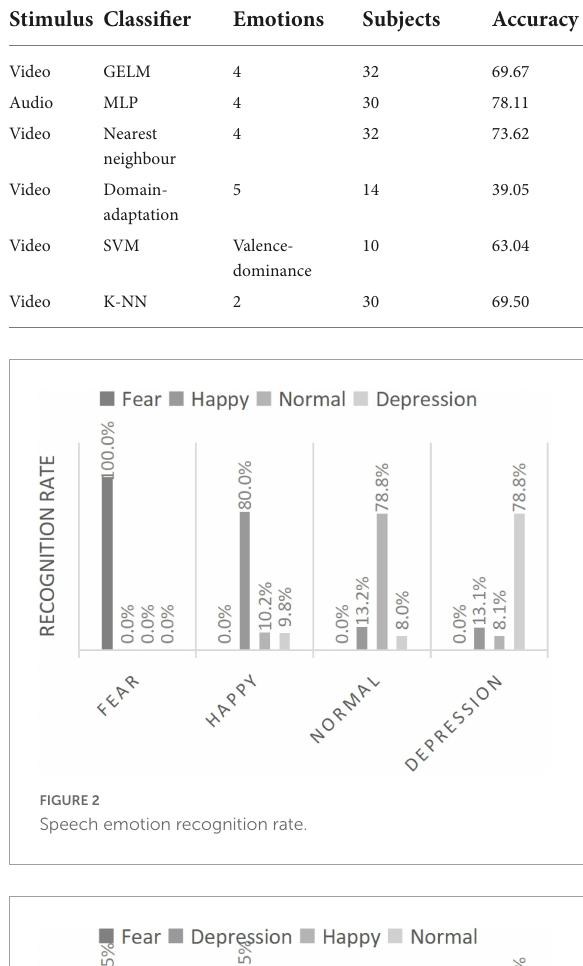
TABLE 4 The integration of voice and facial expression recognition